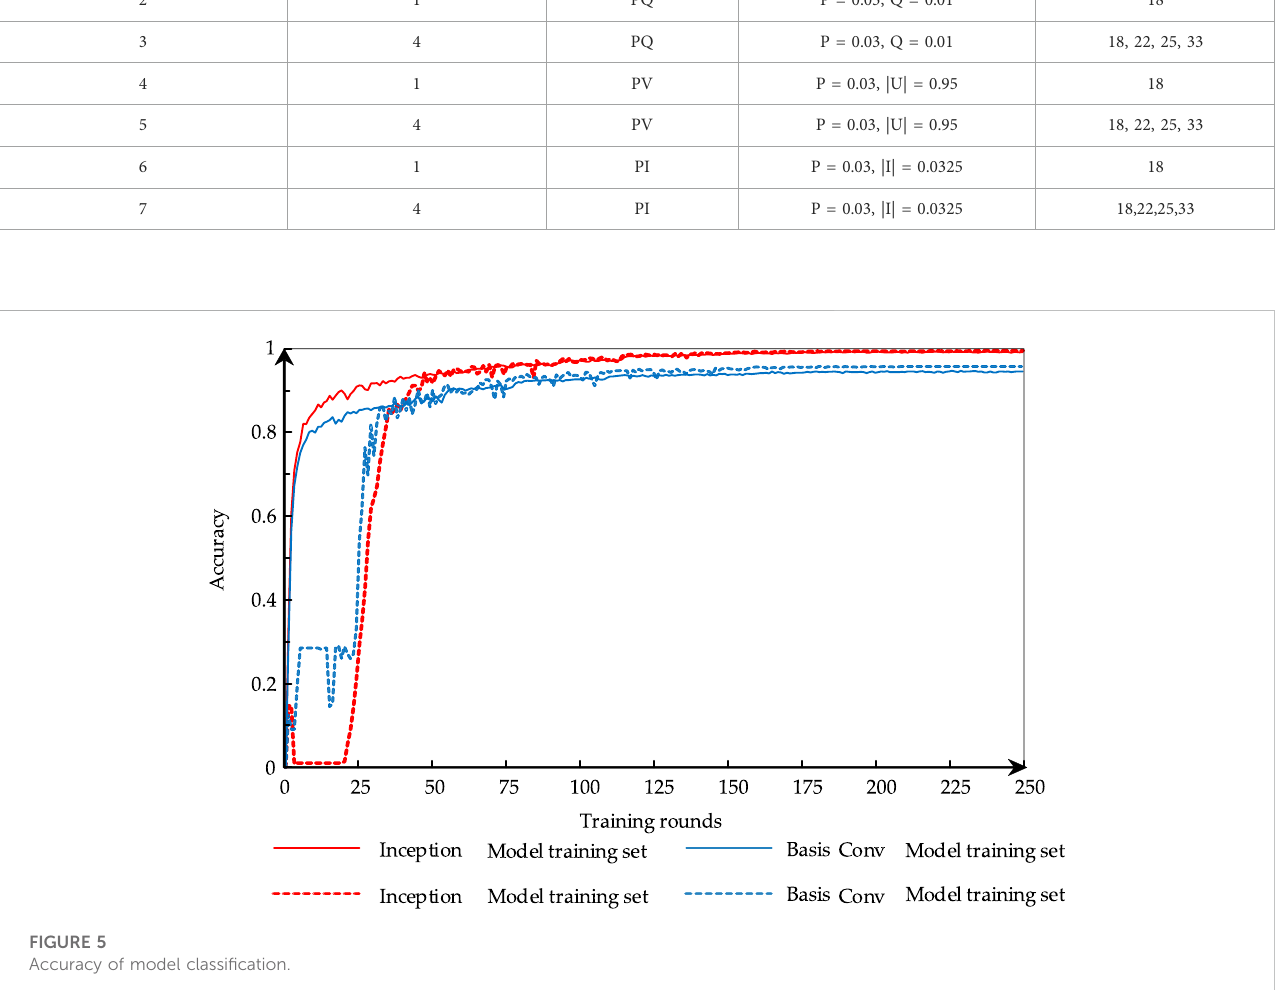
FIGURE 5 Accuracy of model classi fi